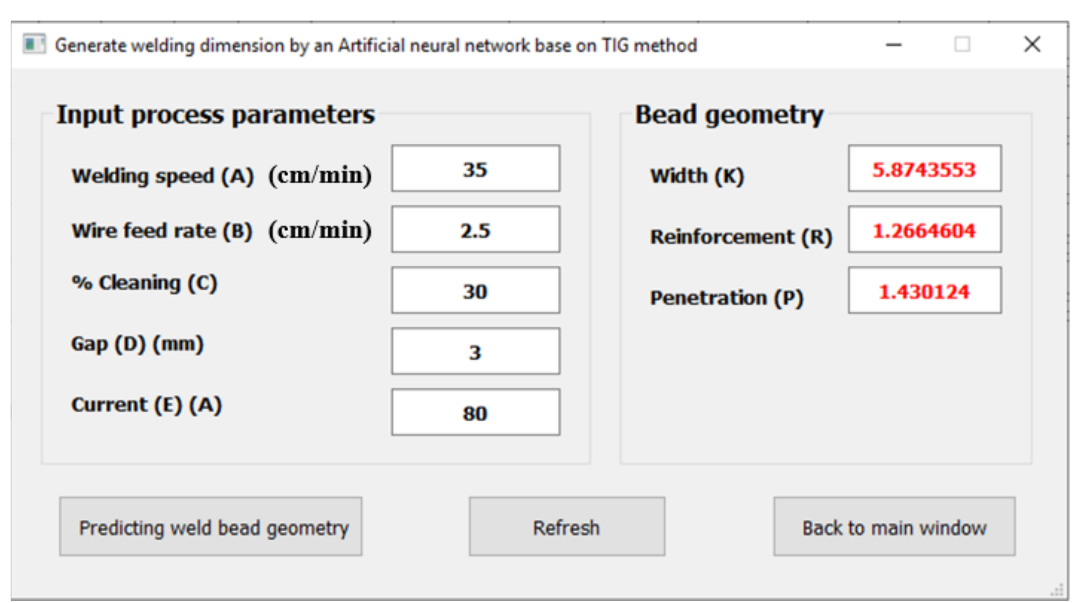
Figure 9. Screenshot of the interface module of the developed predictive system.